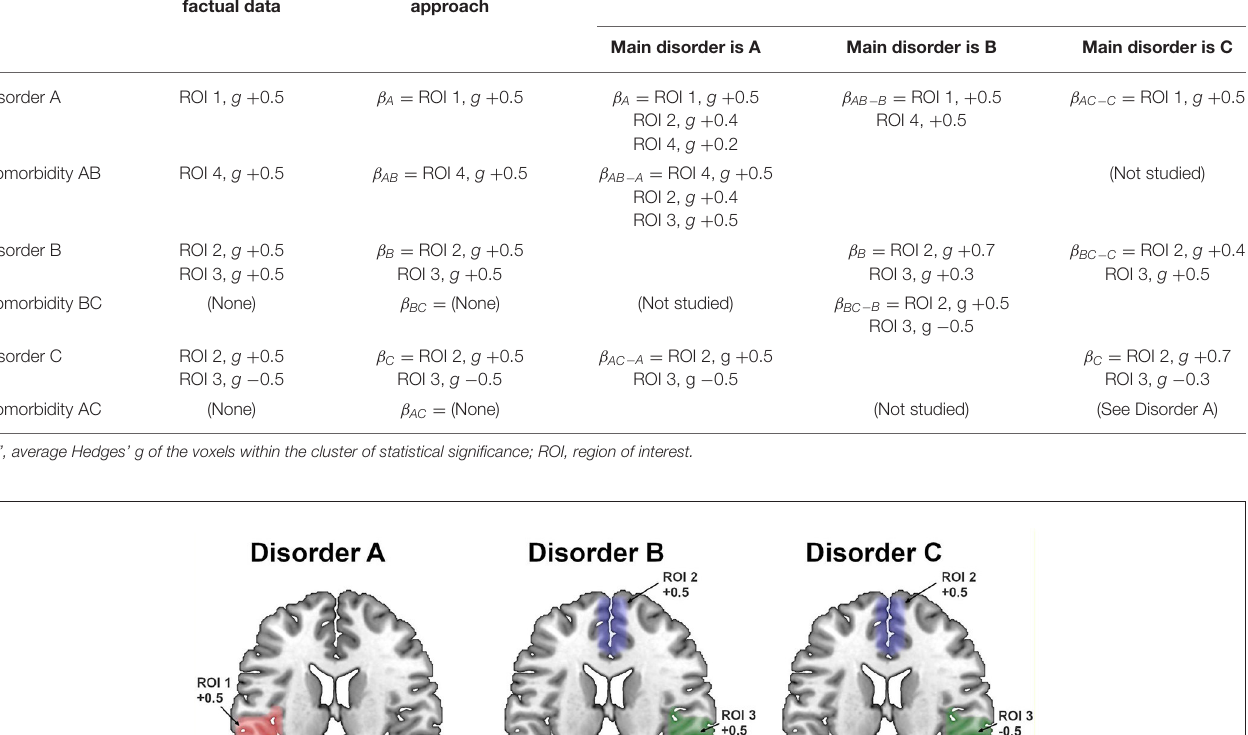
confusing in this example because we would still not know whether abnormality in the region of interest (ROI) 4 is due to disorder A or comorbidity AB. The second limitation was a slight loss of accuracy, as shown by that some Hedges’ g are slightly different from 0.5, and there are a few falsely positive